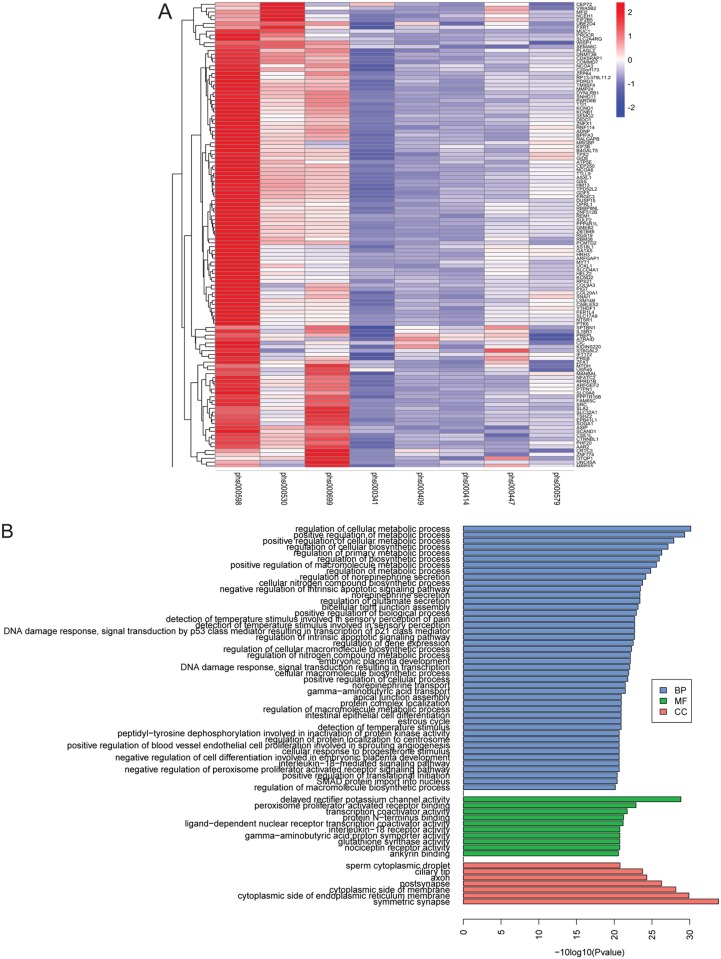
The three low-copy number cancer genome projects have concerted copy number changes in additional genes.(A). The heatmap depicts a cluster of genes with a copy number increase in the three genome projects that have a decrease in rDNA copies. (B). The GO term analysis indicated enrichment for biological processes (BP) such as metabolic process and DNA damage response, molecular functions (MF) such as transcription, and cellular compartments (CC). All terms have a p value less than 0.01 using a hypergeometric test.